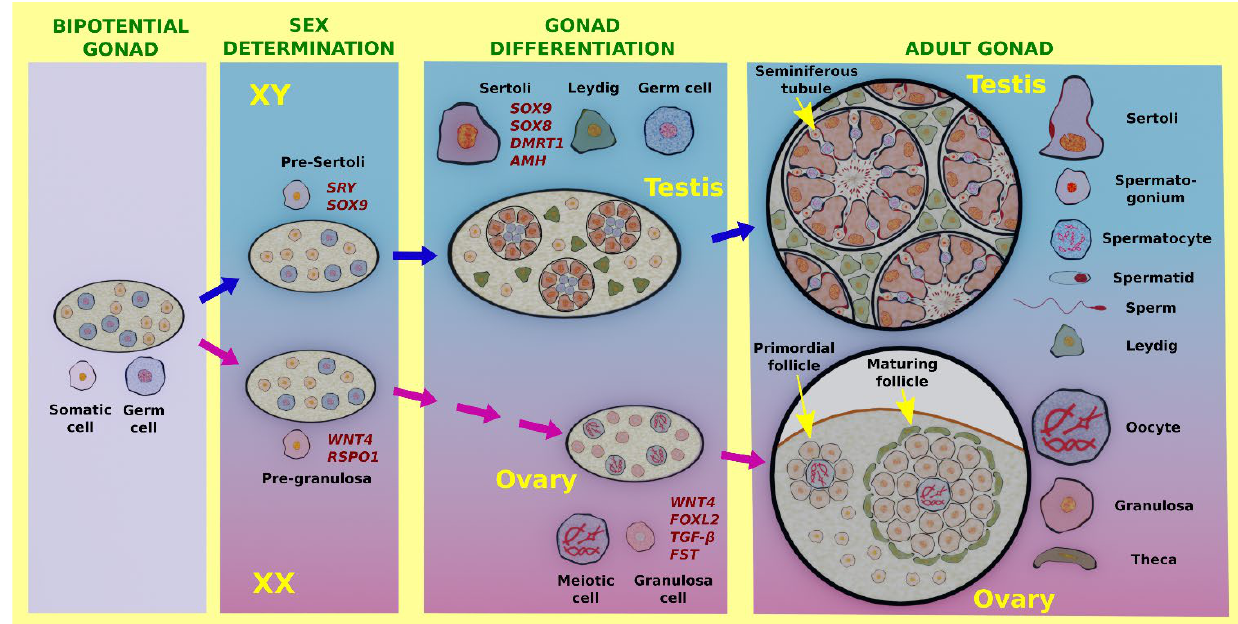
Figure 1. Gonadal cell-fate during gonad differentiation in mice. Prior to the sex determination stage, the bipotential gonad is composed of undifferentiated somatic cells (light pink) and germ cells (light blue). Sex differentiation starts with the specification (commitment) of the supporting cell progenitors to differentiate as either Sertoli cells in the testis or granulosa cells in the ovary. At the sex determination stage in XY individuals, the testis determining gene, SRY , starts to be expressed in the progenitors of the Sertoli cells (pre-Sertoli cells), leading to SOX9 upregulation and Sertoli cell specification. Subsequently, pre-Sertoli cells undergo a mesenchymal to epithelial transition and differentiate into Sertoli cells that form the testis cords enclosing the XY germ cells. Sertoli cells follow a male-specific genetic program expressing genes such as SOX9 , SOX8 , DMRT1 , and AMH promote the differentiation of the steroidogenic Leydig cells and prevent XY germ cells from meiosis entry. In mice, all these events are completed within 24–48 h after sex determination. In the adult testis, cords become seminiferous tubules with lumen and germ cells at different pre-meiotic, meiotic, and post-meiotic stages including spermatogonia, spermatocytes, spermatids, and sperm. In XX gonads, the male pathway is not activated at the sex determination stage due to the lack of SRY and the WNT signaling genes, WNT4 and RSPO1 , are upregulated in pre-granulosa cells. In the mouse, ovary differentiation is delayed with respect to testis differentiation and starts with meiosis initiation by XX germ cells, concomitant with the expression of further ovarian genes and pathways including FOXL2 , TGFβ, and FST . Folliculogenesis is completed after birth, when germ cells are surrounded by a layer of granulosa cells. Follicle maturation in the mouse ovary begins a few days after birth including the proliferation of granulosa cells and the formation of an outer layer of steroidogenic theca cells.